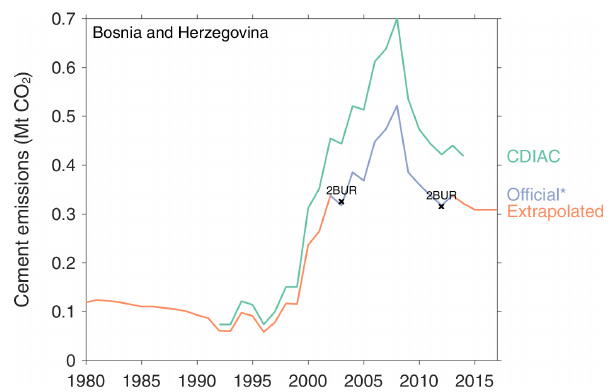
Figure C12. Revised cement emissions in Bosnia and Herzegovina.